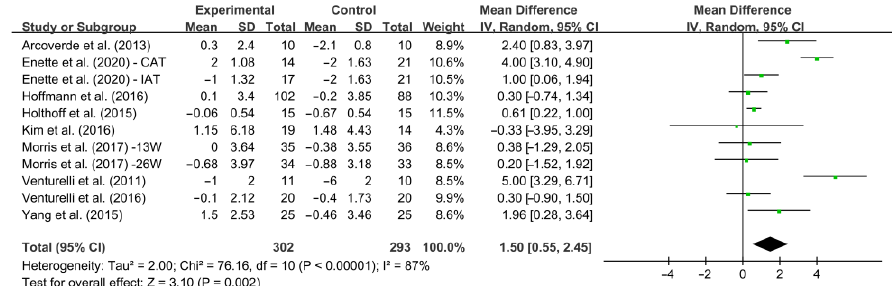
Figure 4. Meta-analysis results of the effect of aerobic exercise on cognitive function in AD patients [20,27,39 – 45].